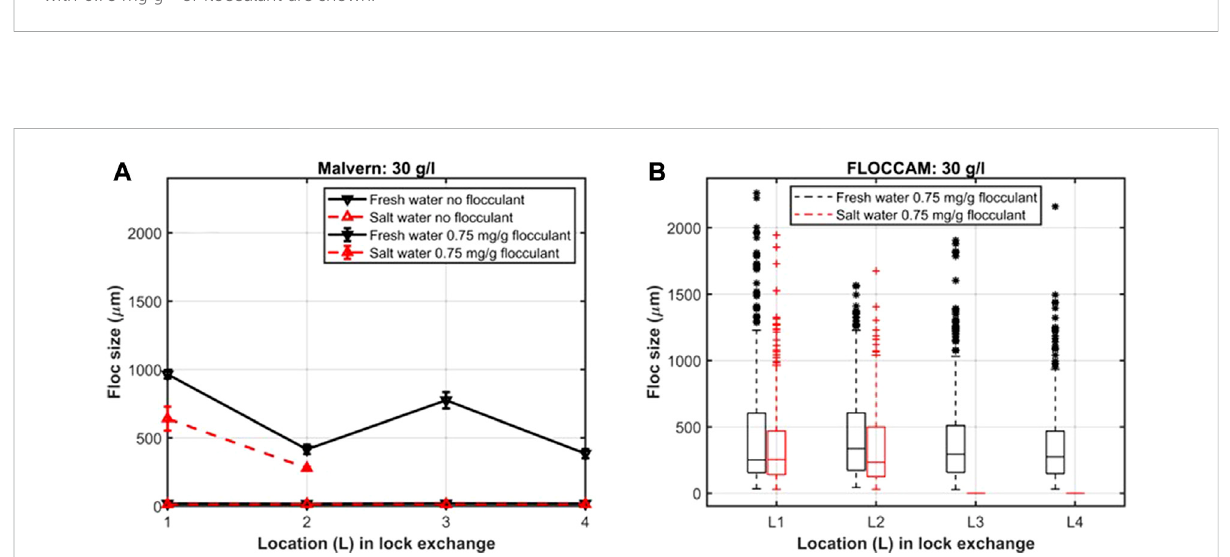
FIGURE 7 Hydrodynamic diameter of ACCZ fl ocs for 30 g L − 1 experiments at L1-L4 locations of the lock exchange (Ali et al., 2022). Figure (A) , results obtained by SLS and fi gure (B) , results obtained from FLOCCAM. Black and red lines represent experiments done in freshwater and saltwater, respectively. Only results with 0.75 mg g − 1 of fl occulant are